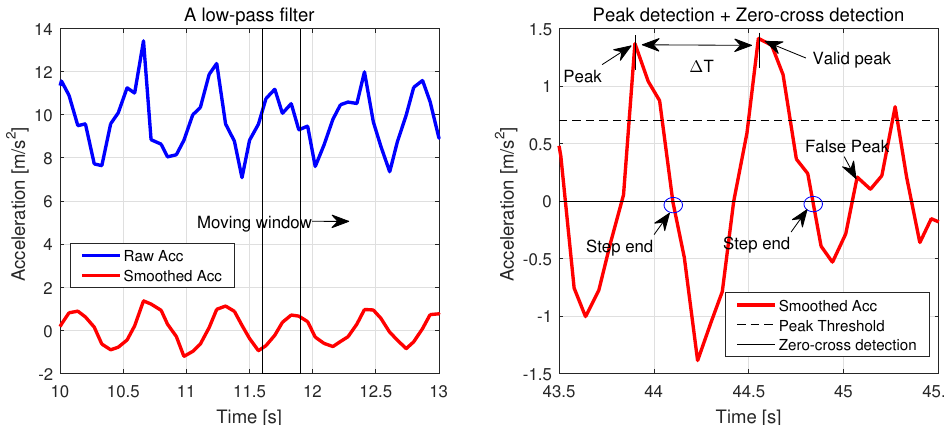
Figure 6. The left panel denotes the low-pass filtering method by a moving averaging window, and the right panel shows the peak selection and the determination of step end. The occurrence of a valid peak and step end within one cycle will account for one step.